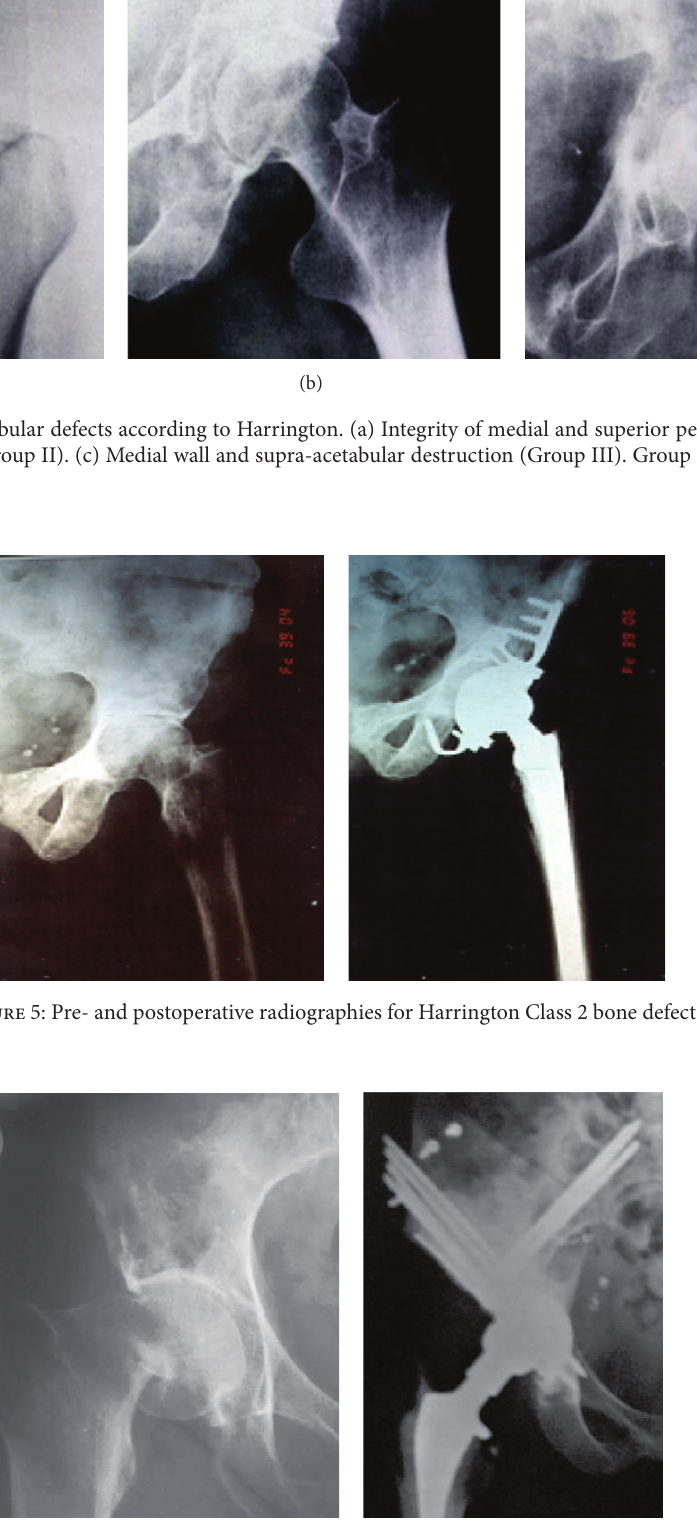
Figure 6: Pre- and postoperative radiographies of Class 3 acetabular defect using the Harrington technique for